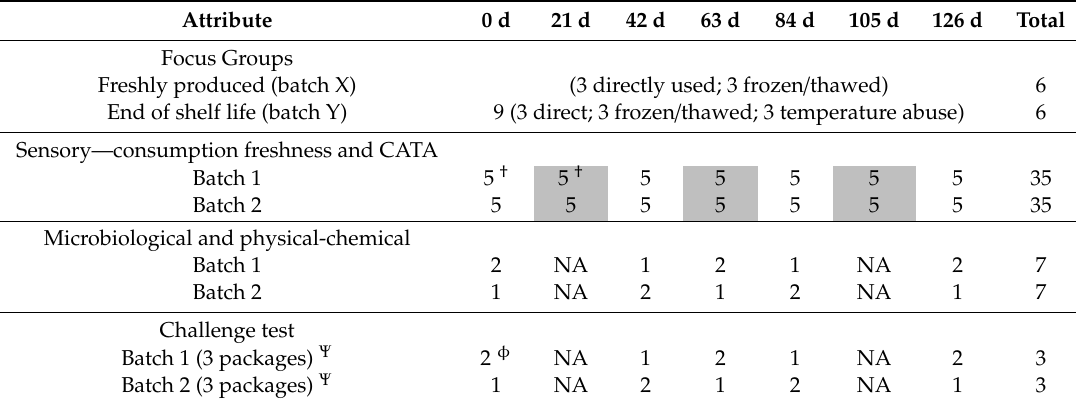
Table 1. Sampling scheme. Number of packages with approximately 10 slices each (except the challenge test, which contained five slices each). Attribute 0